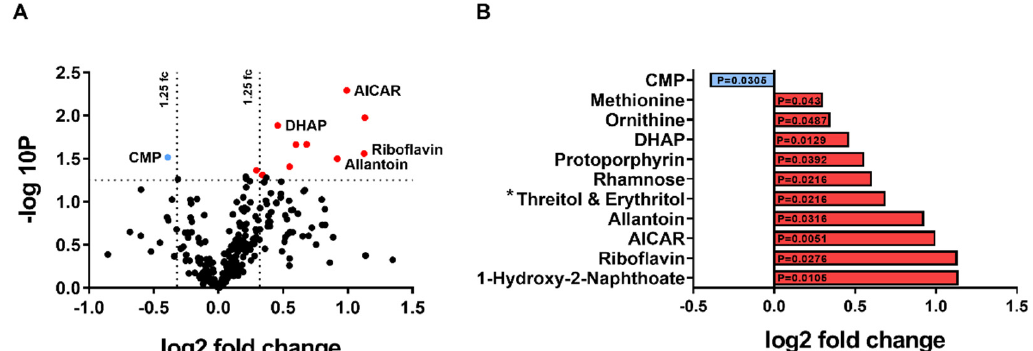
Figure 2. Kidney metabolomic analysis of KPTC-GLUT2 null Akita diabetic mice. We utilized our KPTC-GLUT2 null Akita diabetic mouse model and performed an unbiased metabolomic analysis on their kidney lysate. The volcano plot shows 11 metabolites that were found to be significantly changed in Akita-KPTC GLUT2-/- mice (n = 11), compared with Akita-KPTC GLUT2+/+ WT littermates (n = 10) ( A ), the fold change and P value for the significantly changed metabolites ( B ). AICAR, 5-Aminoimidazole-4-Carboxamide Ribonucleotide; DHAP, Dihydroxyacetone Phosphate; CMP, Cytidine Monophosphate; * Threitol and Erythritol are isobars, which do not separate chromatographically in our method.